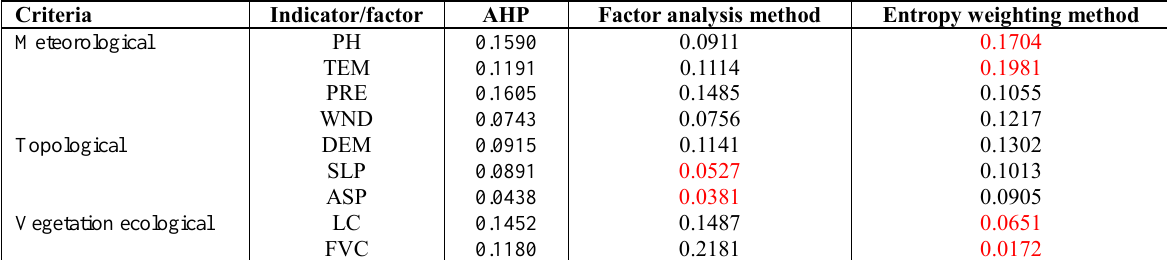
Table 4 . Analysis of FRP weight calculation